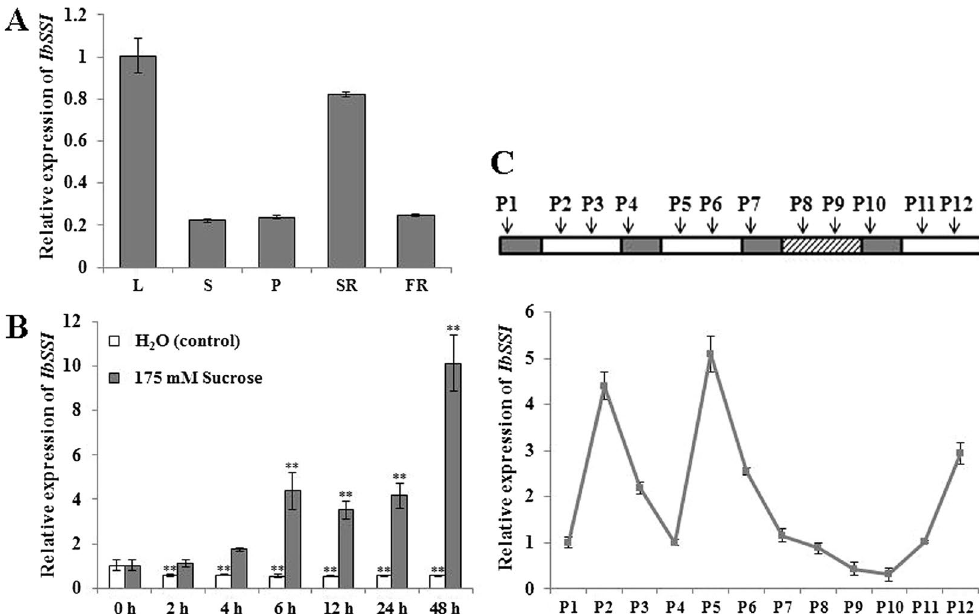
Figure 2. Expression analysis of IbSSI in the sweet potato. ( A ) Transcript levels of IbSSI in different tissues of the sweet potato detected by qRT-PCR. L, leaf; S, stem; P, petiole; SR, storage root; FR, fibrous root. ( B ) Expression profile of IbSSI in response to 175 mM sucrose treatment. ( C ) Time course of IbSSI expression detected by qRT-PCR during 16 h light/8 h dark photoperiods with light on at 5 am and off at 9 pm. Total RNA was extracted from the in vitro -grown whole plant sampled at 10 pm (P1, P4, P7 and P10), 10 am (P2, P5, P8 and P11) and 4 pm (P3, P6, P9 and P12), respectively. The open bars represent the 16 h light period, the solid bars correspond to the 8 h dark period, and the hatched bars indicate the extended dark period that would otherwise be the light period. The results are expressed as relative values with respect to the L, 0 h and P1, which were set to 1.0 in ( A–C ), respectively. Data are presented as the mean ± SD (n = 3). ** Indicates a significant difference versus the control at P < 0.01 based on Student’s t -test.